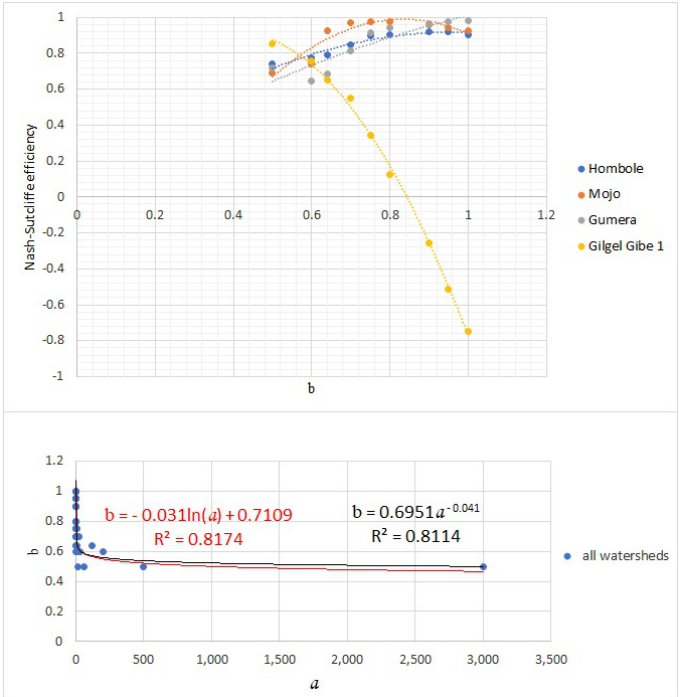
Figure 26. The relationship between exponent b versus the Nash–Sutcliffe efficiency and the coeffi- cient a versus the exponent b when the topographic factor is calculated using the Chines